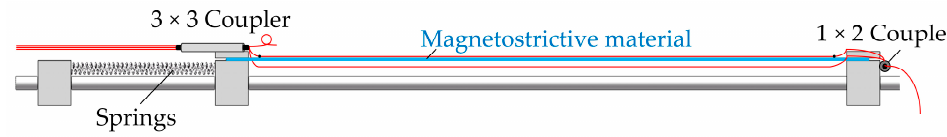
Figure 2. The fiber magnetic sensor structure design.